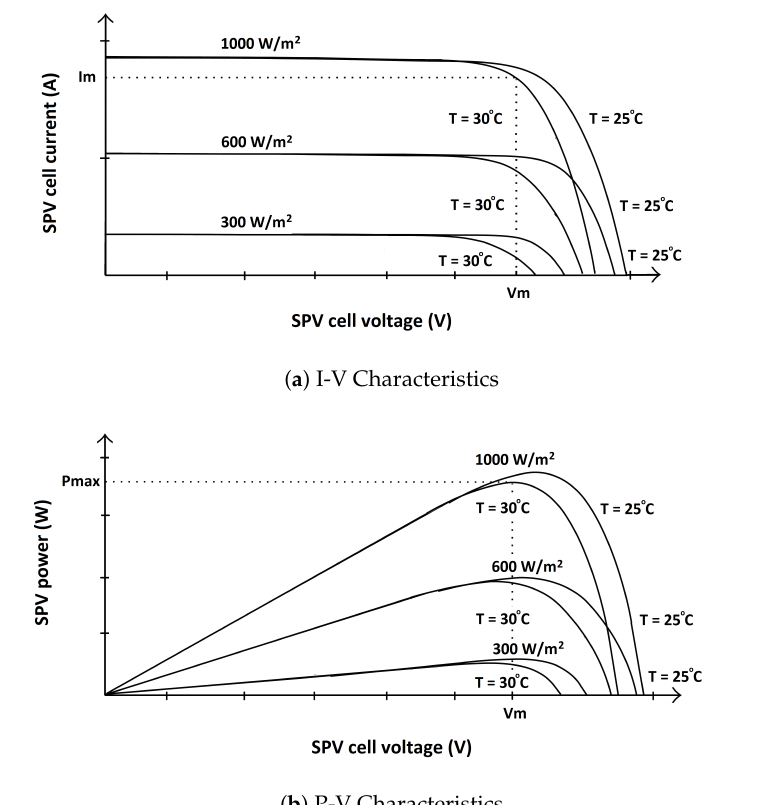
Figure 1. Characteristics of Solar-PV under different irradiance and temperature